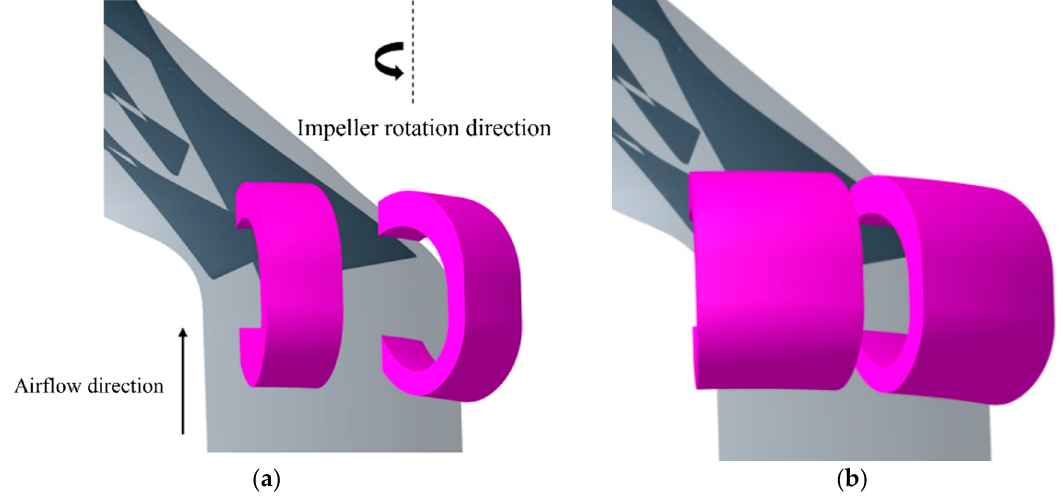
Figure 3. The three-dimensional structure of self-circulating casings. ( a ) SRCC0.36. ( b )